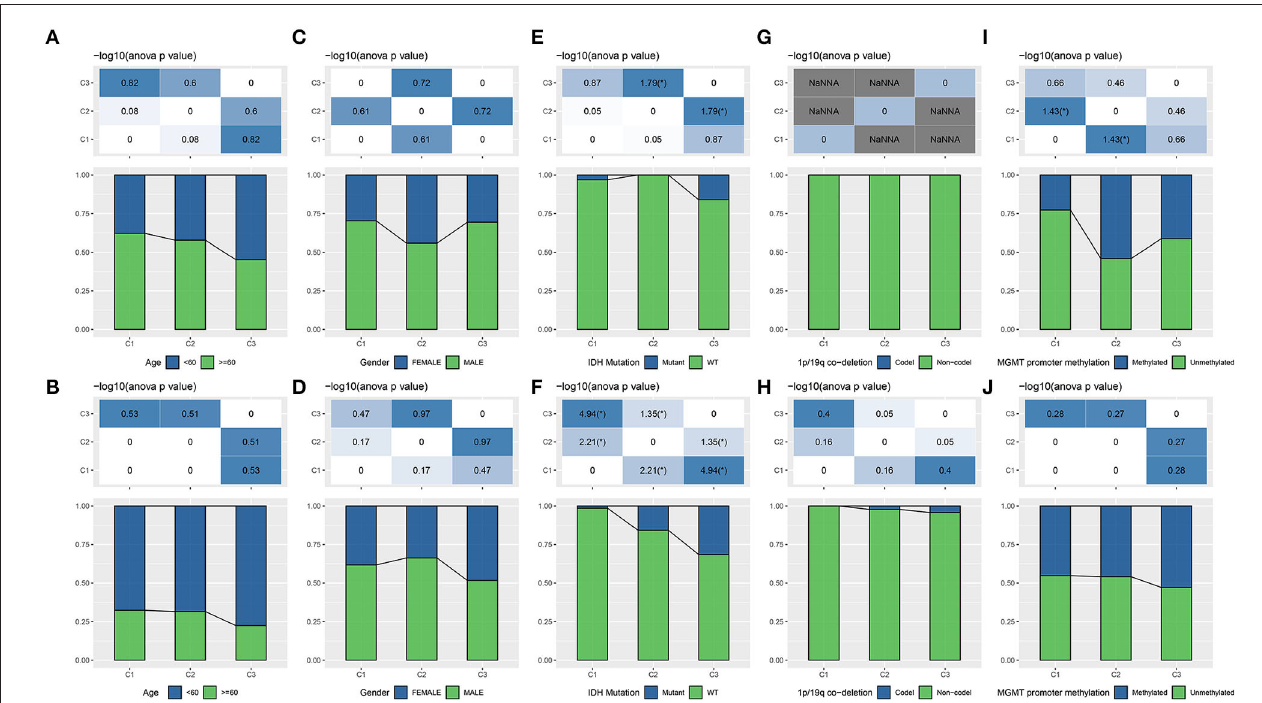
FIGURE 2 | The distribution of different clinical features including age (A,B) , gender (C,D) , and molecular features including IDH (E,F) , 1p/19q co-deletion (G,H) , MGMT promoter methylation (I,J) in three subtypes. The upper group is TCGA-GBM dataset and the lower group is CGGA-GBM dataset. ANOVA was conducted. * p < 0.05. NaNNA, no available data. IDH, isocitrate dehydrogenase; GBM, glioblastoma; TCGA, The Cancer Genome Atlas; CGGA, Chinese Glioma Genome